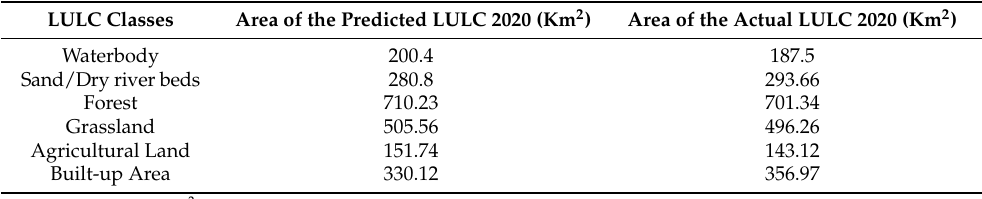
Table 14. Validation of the change prediction based on actual and predicted 2020 LULC